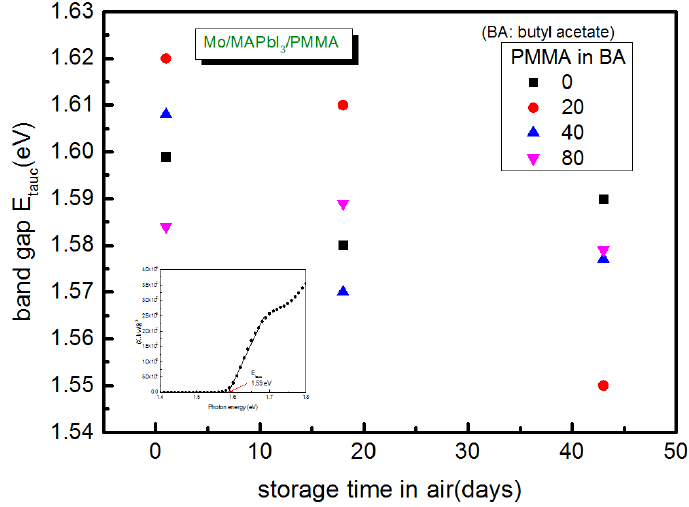
Figure 7. Band gap ( E tauc ) for 0 mg/mL of (circle closed black rectangle), 20 mg/mL (closed red circle), 40 mg/mL (closed blue triangle), and 80 mg/mL (closed pink triangle) as a function of storage time in air on the 1st, 18th, and 43rd day. Inset shows Tauc plot for perovskite coated with 40 mg/mL of PMMA.